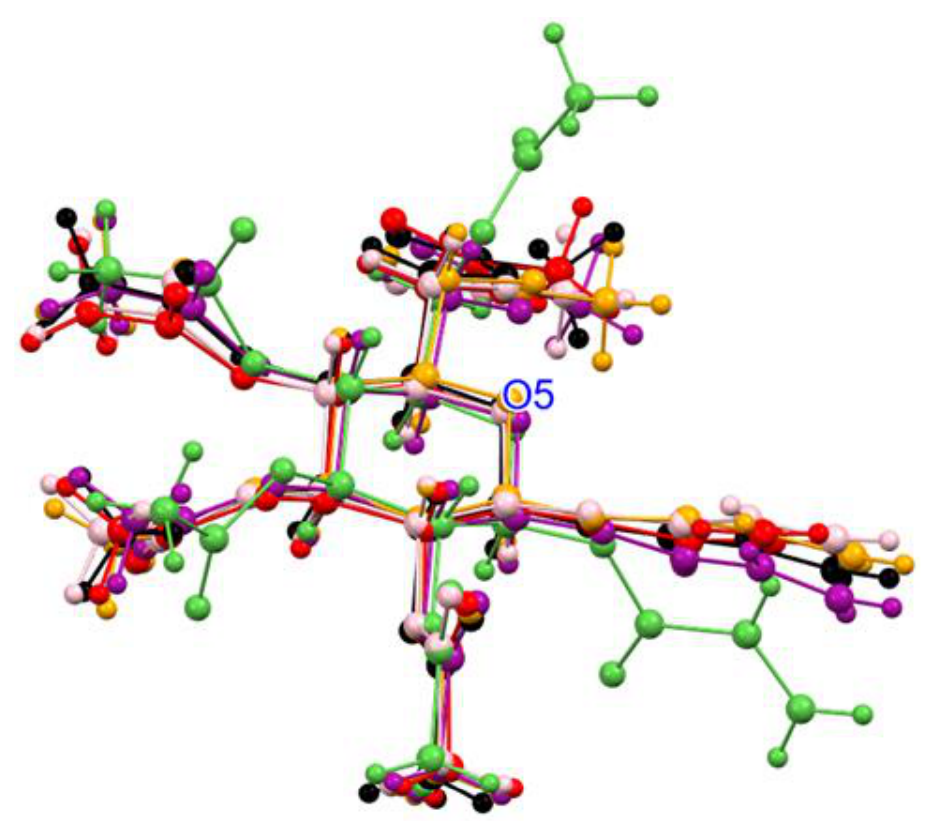
Figure 8. The overlay of the AGlc conformers present in the asymmetric part of the unit cell in the crystals: AGlc- M (black line), AGlc- O (molecule A — green line and B — violet line), and AGlc- M - LT (molecule A — pink line, B — red line, and C — orange line).